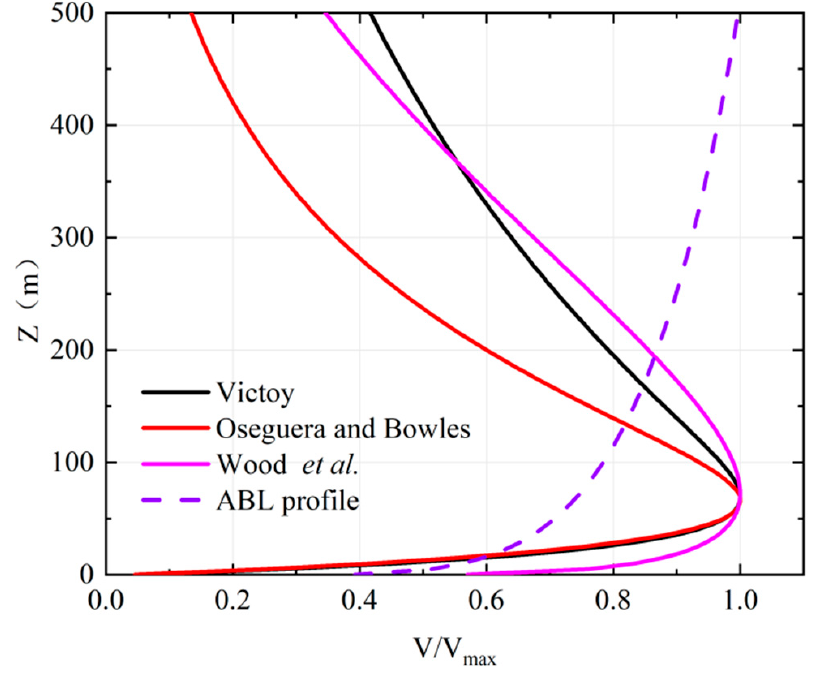
Figure 3. Comparison among three profile models and conventional ABL profile.